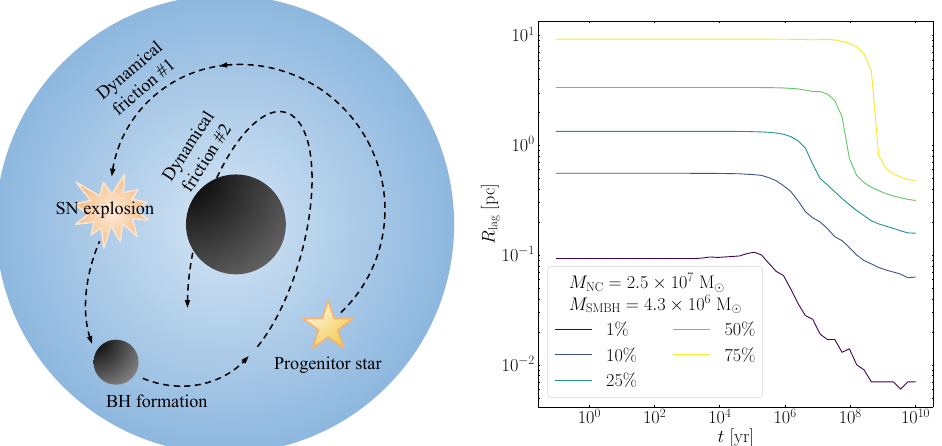
Figure 4. Left panel: schematic view of the orbit of a BH progenitor in a galactic nucleus. The occurrence of an SN event can impart a kick on the newborn BH and delay the segregation. Right panel: Lagrangian radii enclosing 10%, 25%, 50%, and 75% of the BH (or BH progenitor) mass as a function of time assuming a nucleus with mass M c = 2.5 M SMBH = 4.3 10 6 M × (cid:12)